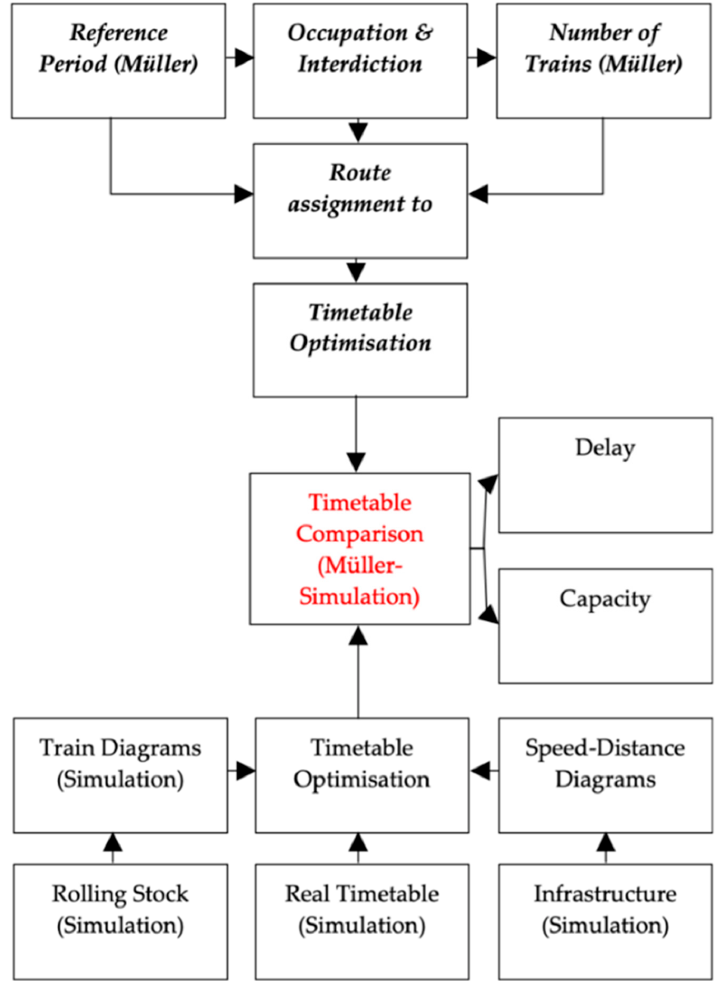
Figure 5. Müller and simulation methods integrated procedure.